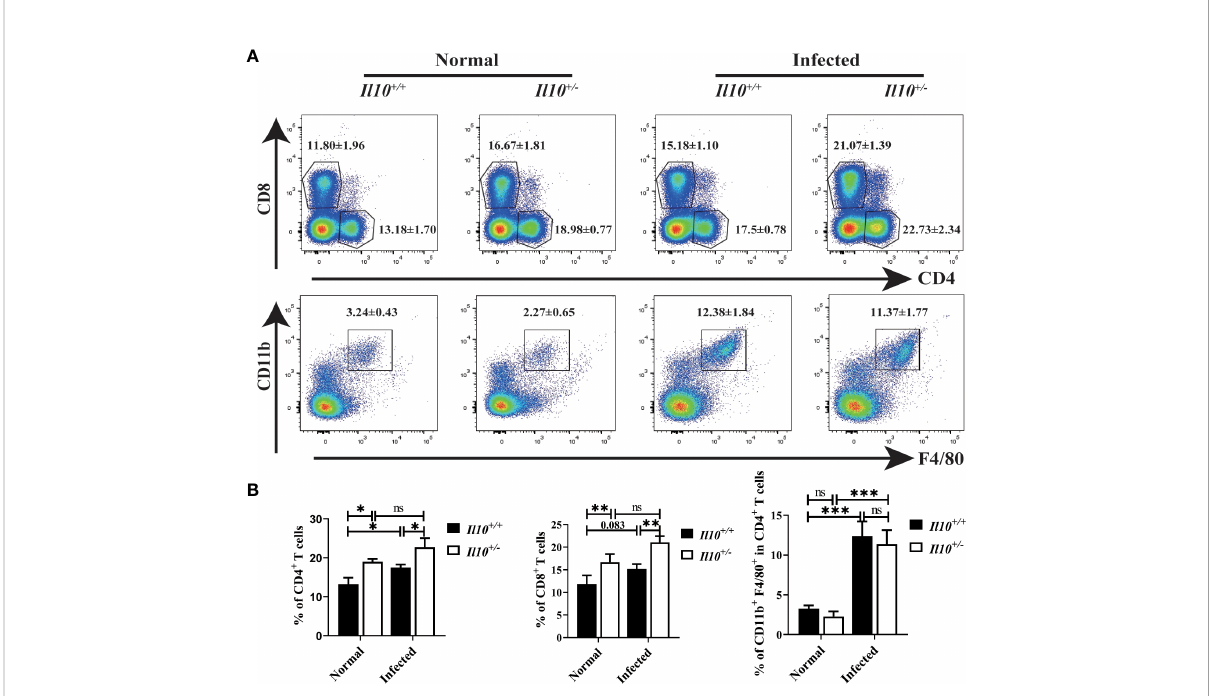
FIGURE 2 T cells but not macrophages are increased in clonorchiasis of Il10 +/- mice. The mice were sacri fi ced at 6 wpi, and white blood cells were isolated from livers for CD4 + T cells, CD8 + T cells, and macrophages detection by fl ow cytometry. (A) The expressions of CD4, CD8, F4/80, and CD11b in white blood cells were analyzed by fl ow cytometry. (B) The ratio of CD4 + T cells, CD8 + T cells, and F4/80 + CD11b + macrophages was analyzed by FlowJo V10.8.1 software. Compared with indicated group, * P < 0.05, ** P < 0.01, *** P < 0.001, ns, no signi fi